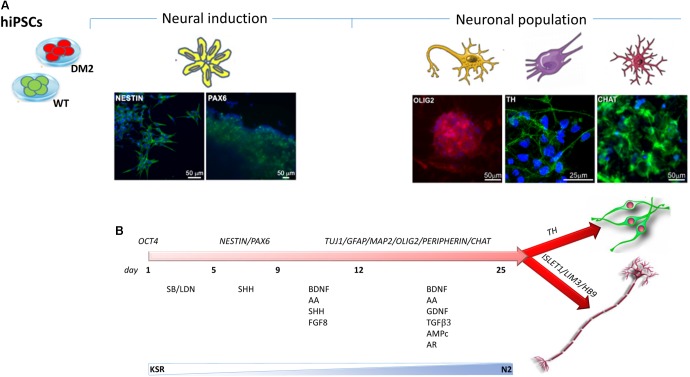
Timeline of hiPSCs differentiation into NPs. (A) Immunostaining has been performed using antibodies specific to neural stem cell markers NESTIN (green) and PAX6 (green) and to specific markers for NP as OLIG2 (red), CHAT (green), and TH (green). 4,6-Diamidino-2-phenylindole (DAPI) nuclear staining in blue. Scale bars = 50 and 25 μm. (B) Neuronal differentiation is obtained by SMAD signaling modulation via treatment with SB431542/LDN. The timing of differentiation represents the day at which several factors have been added and the crucial stages of differentiation from hiPSCs to NPs through the neural induction.